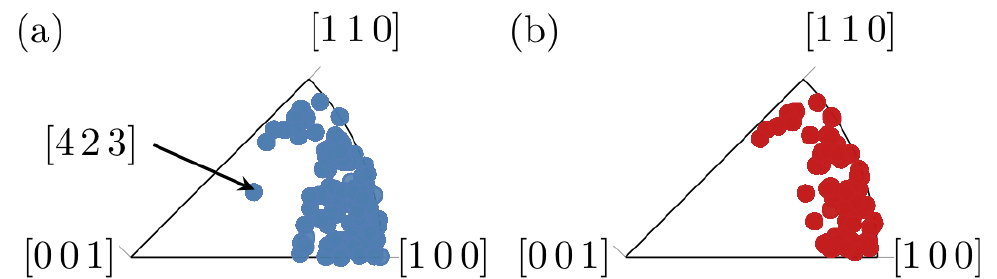
Figure 4. 3D reconstruction of the microstructure of the tin coating, the volume is sliced to reveal the columnar structure of the tin grains and the Cu are coloured based on the crystal direction parallel to the sample normal: ( a ) before heat treatment; and ( b ) after heat treatment of 150 ◦ C for three hours.